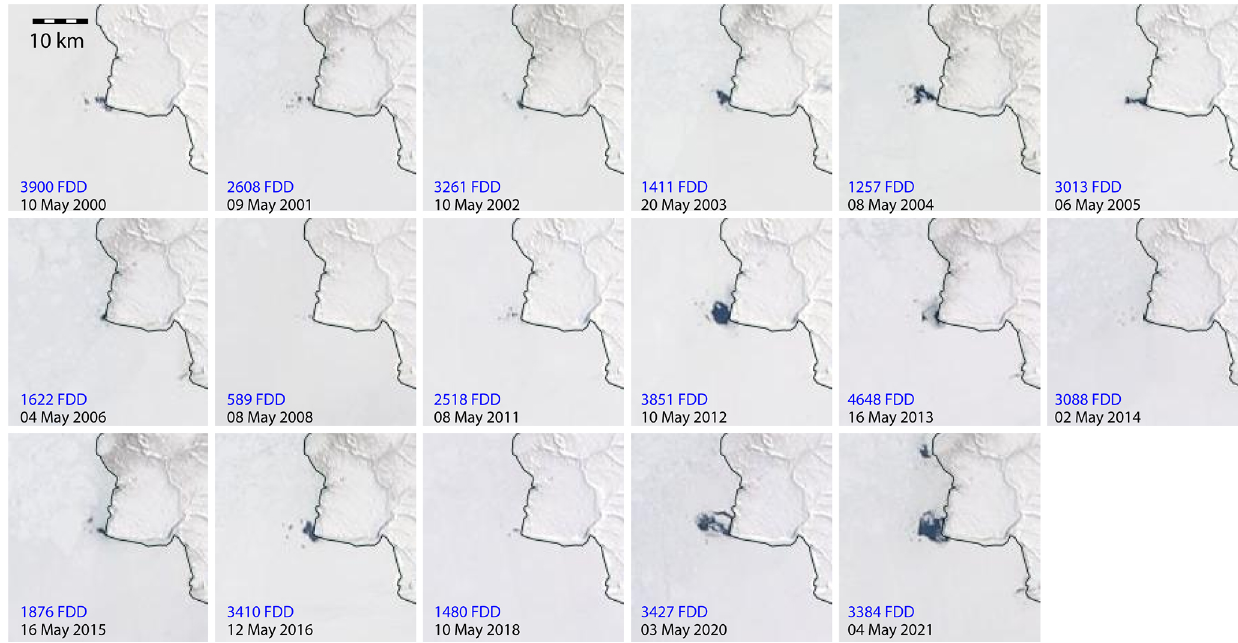
Figure 2. The presence of sensible heat polynya at Cape Jackson during winters when ice bridge in Nares Strait formed between 2000 and 2021 in MODIS imagery from the NASA MODIS instrument. Blue numbers correspond to the sum of freezing degree days (FDDs) from a corresponding date of bridge formation (see Kirillov et al., 2021) to 30 April. Each panel is 37 . 5 × 37 . 5km.